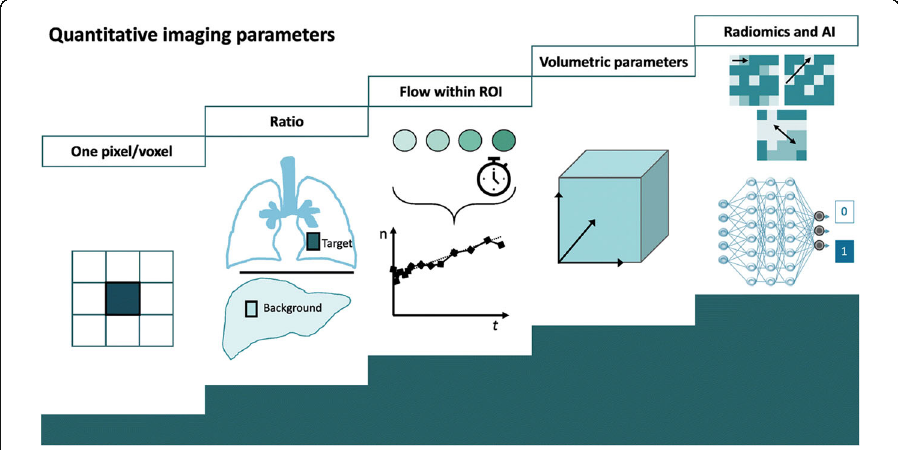
Fig. 2 Types of quantitative approaches in imaging (reprint with permission from (Sollini et al.